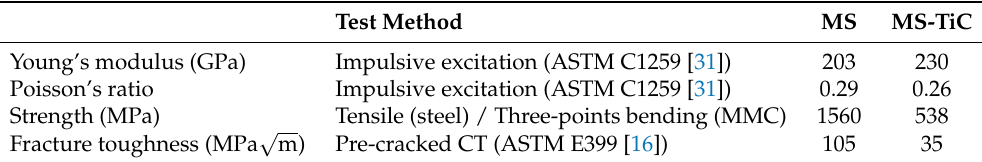
Table 1. Mechanical properties of the materials used in this